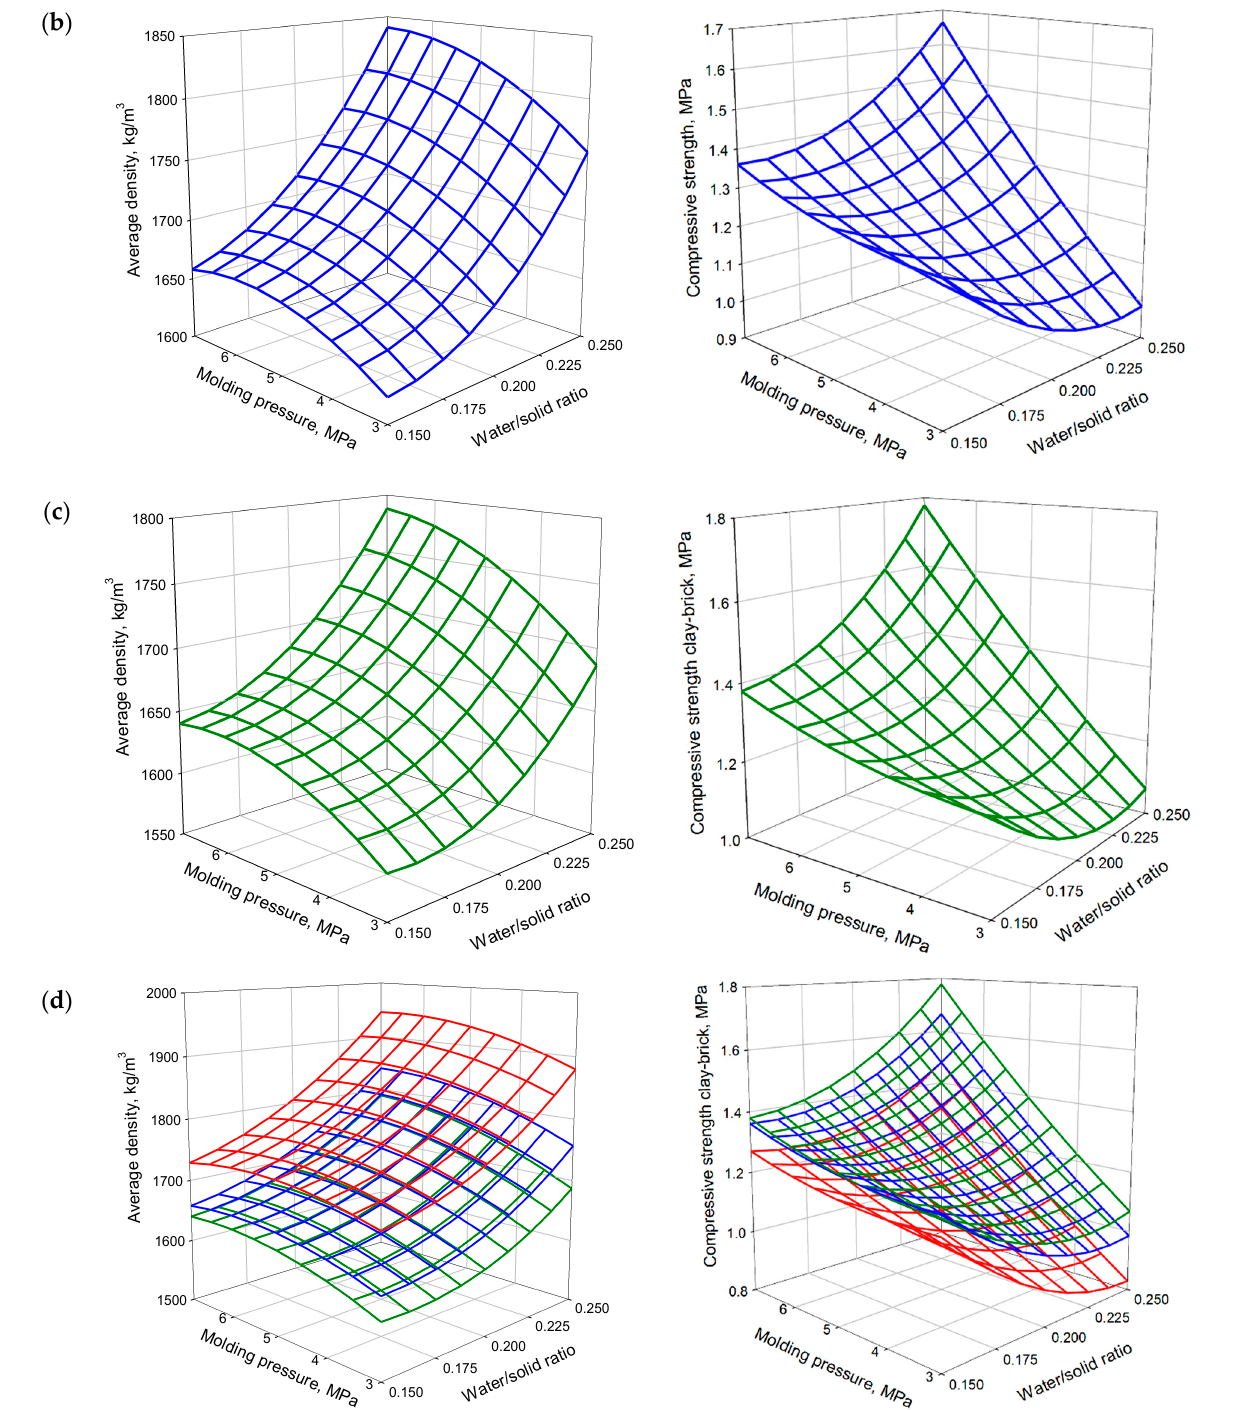
Figure 1. The effect of molding pressure and W/S ratio on the average density and compressive strength of samples immediately after demolding at the different FCG contents in the raw mixture: ( a ) 10%; ( b ) 30%; ( c ) 50%; ( d ) combined nomogram.